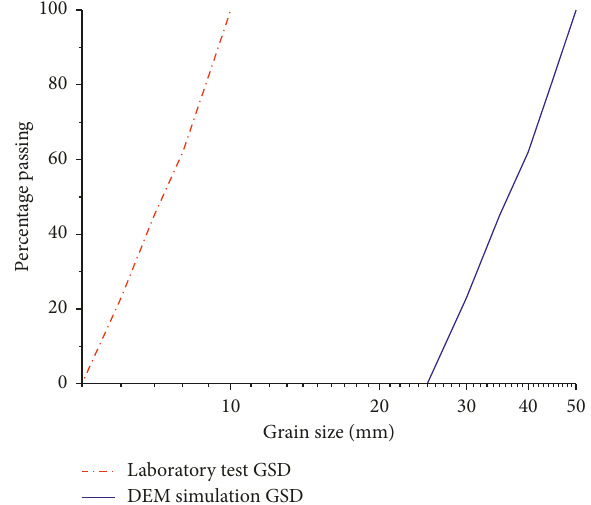
Figure 1: Grain size distribution curves of DEM simulation and of laboratory test.